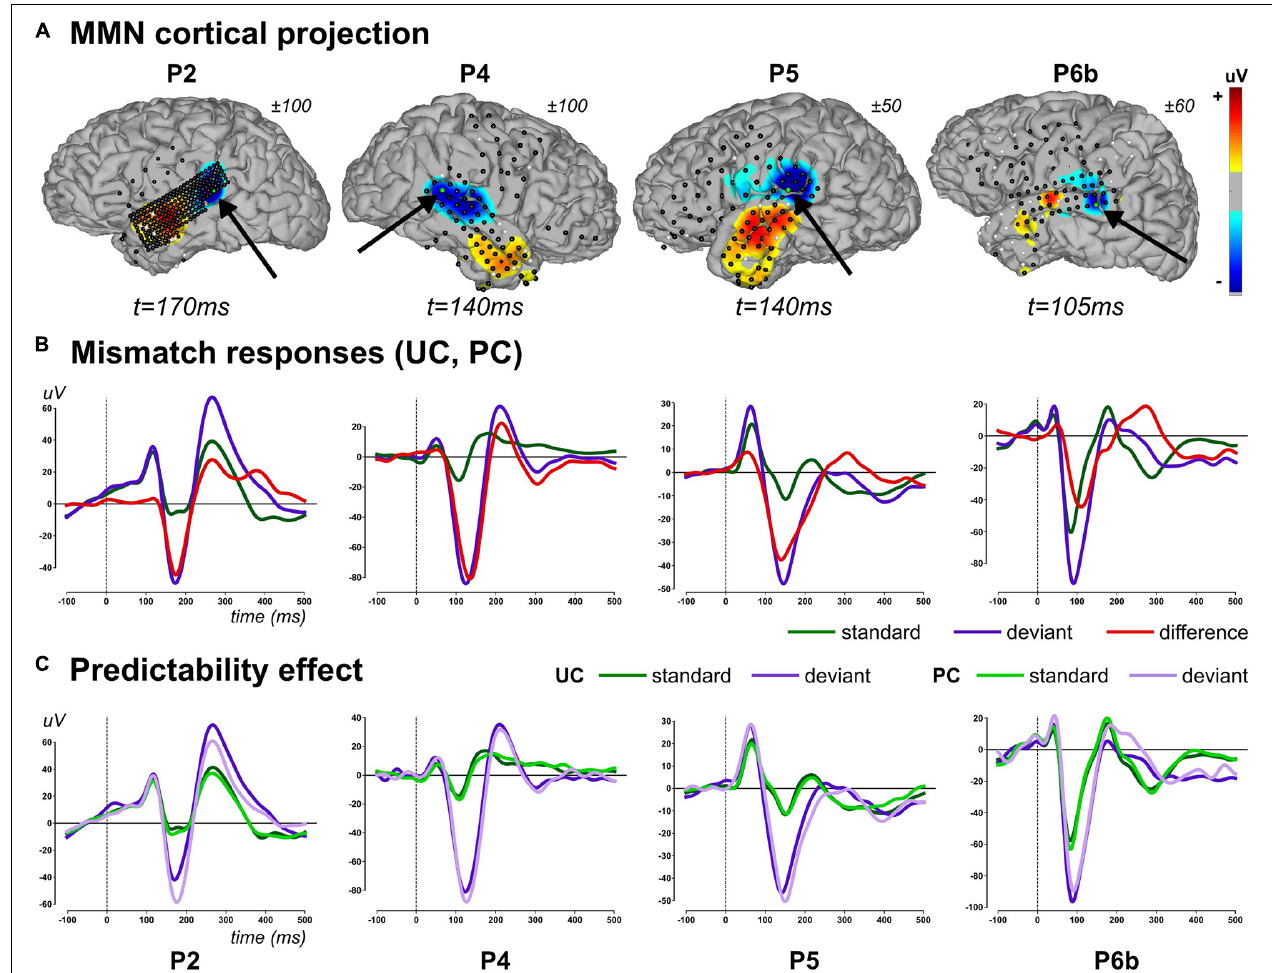
FIGURE 5 | Mismatch evoked responses (2–20Hz). (A) Projection of difference responses (deviant–standard) around the MMN peak onto cortical surface (linear projection based on sensor-to-mesh distance), for each patient (columns). Latency and amplitude range are provided for each patient. Sensor overlay: black and white dots represent good and bad sensors, respectively. For each cortical map, black arrow points to a relevant electrode (green dot) showing an MMN, whose evoked activity is provided in lower panel. (B) Average evoked activity across contexts (UC and PC) for standard (all of them including those of rank 1), deviant stimuli, and their difference for each patient (column), at a particular electrode (highlighted in panel A ). (C) Evoked standard and deviant responses at the same electrode in context UC and PC. Panels (B,C) : traces are baseline corrected (–100 to 0 ms) and follow the color code